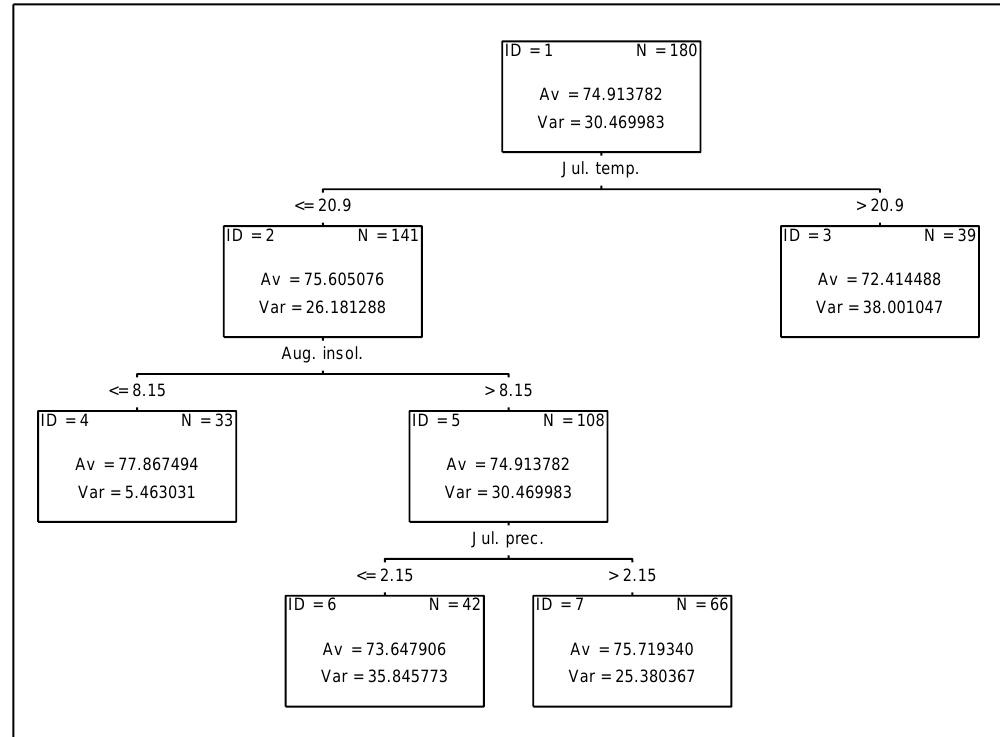
Figure 10. Diagram of regression tree reflecting nitrogen acquisition from soil by control soybean plants.